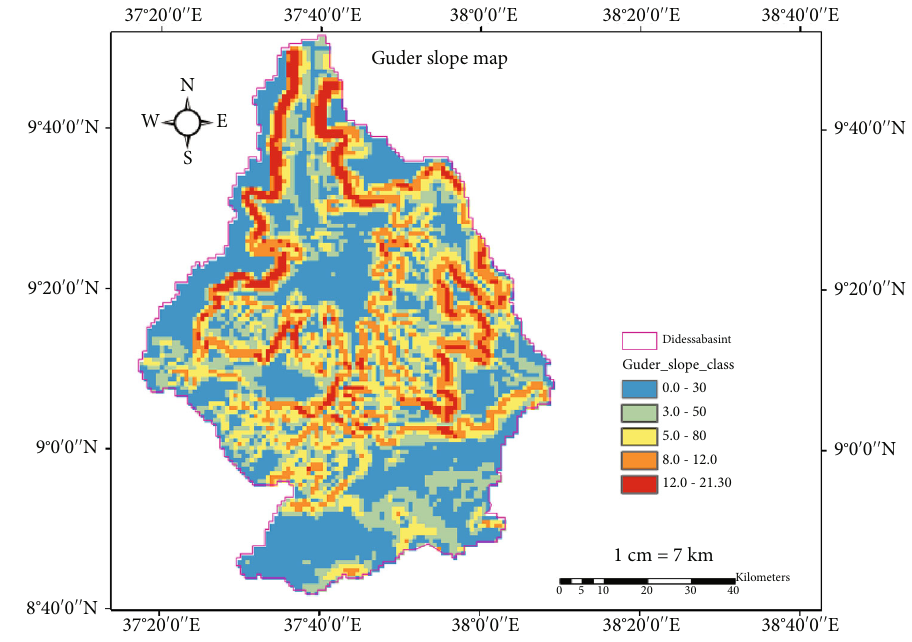
Figure 10: Slope map of the study